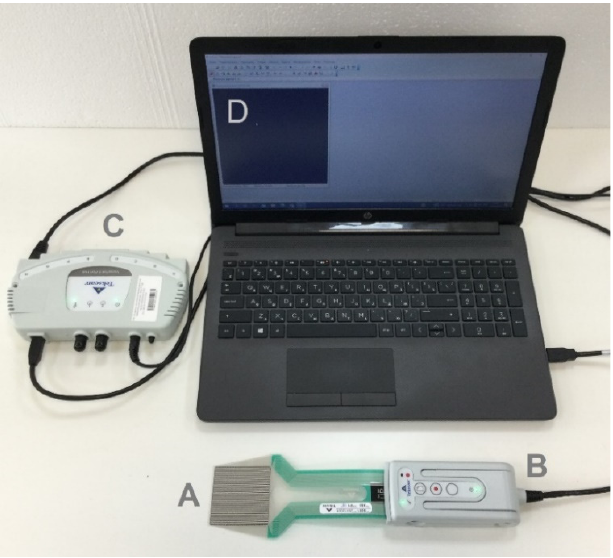
Figure 3. Pressure measuring equipment (Tekscan): ( A )—sensor 5051; ( B )—VersaTek Handle; ( C )— VersaTek Hub; ( D ) Laptop with I ‐